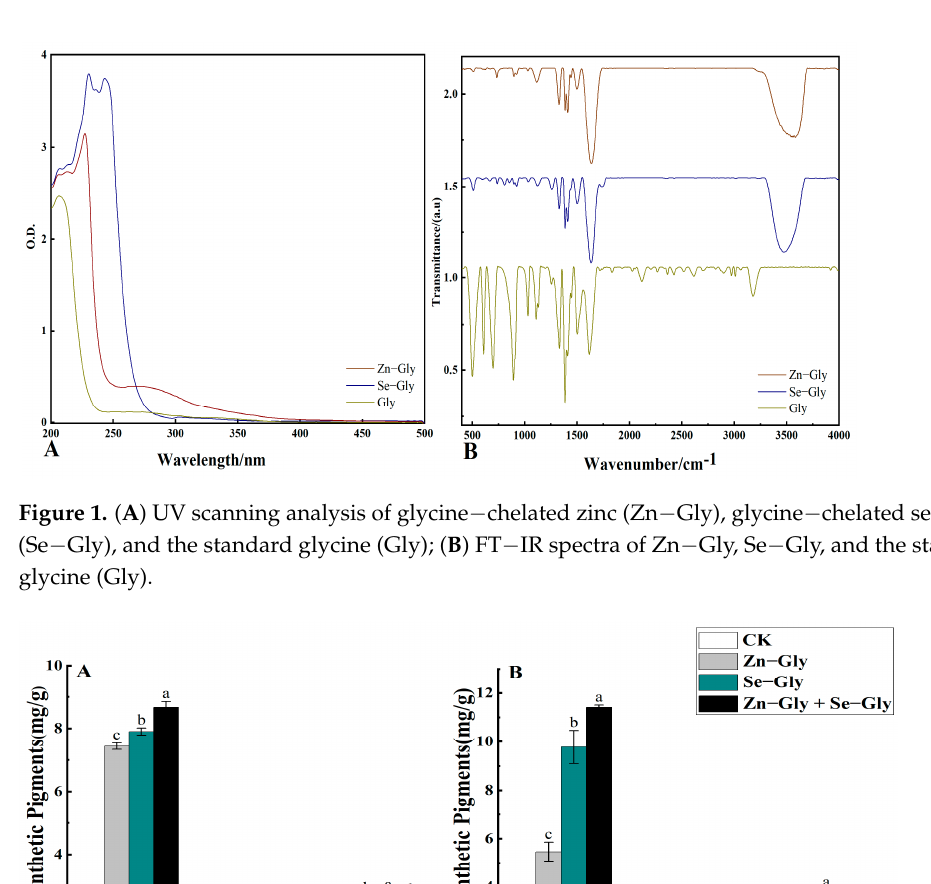
Figure 1. ( A ) UV scanning analysis of glycine − chelated zinc (Zn − Gly), glycine − chelated selenium (Se − Gly), and the standard glycine (Gly); ( B ) FT − IR spectra of Zn − Gly, Se − Gly, and the standard glycine (Gly).